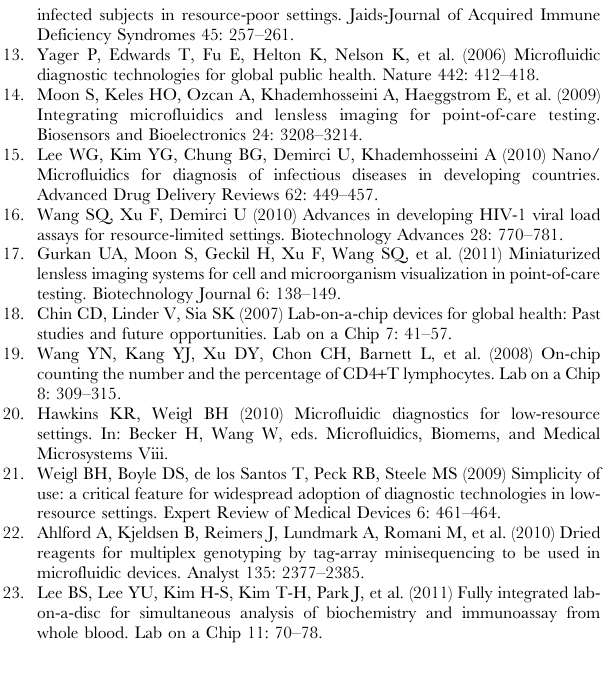
Figure S3 A brief description of the surface chemistry protocol to immobilize antibodies in microfluidic chips.